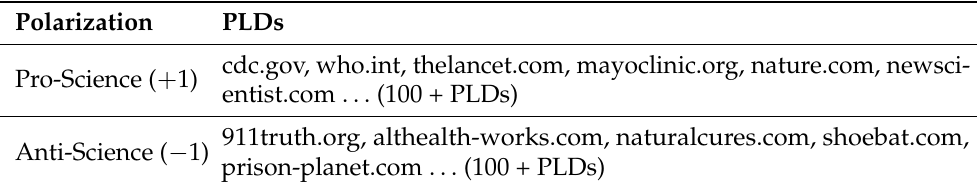
Table 1. Curated information and news domains (PLDs) with their polarization. Examples of the pro-science and anti-sciences domains are shown in the